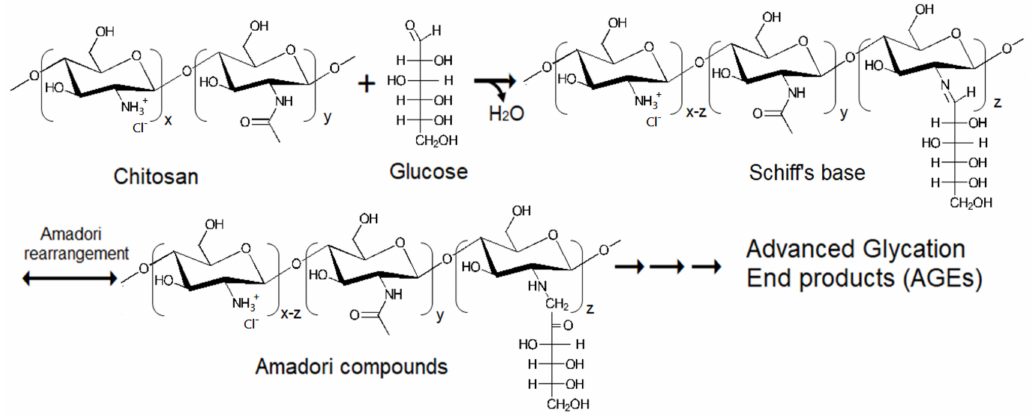
Figure 1. Maillard reaction of water-soluble chitosan (WSC) and